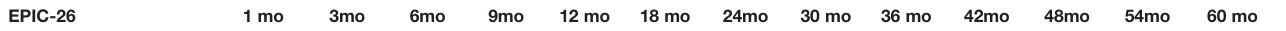
TABLE 4 | EPIC-26 summary score changes and proportions of patients with declines above the minimally important difference. EPIC-26